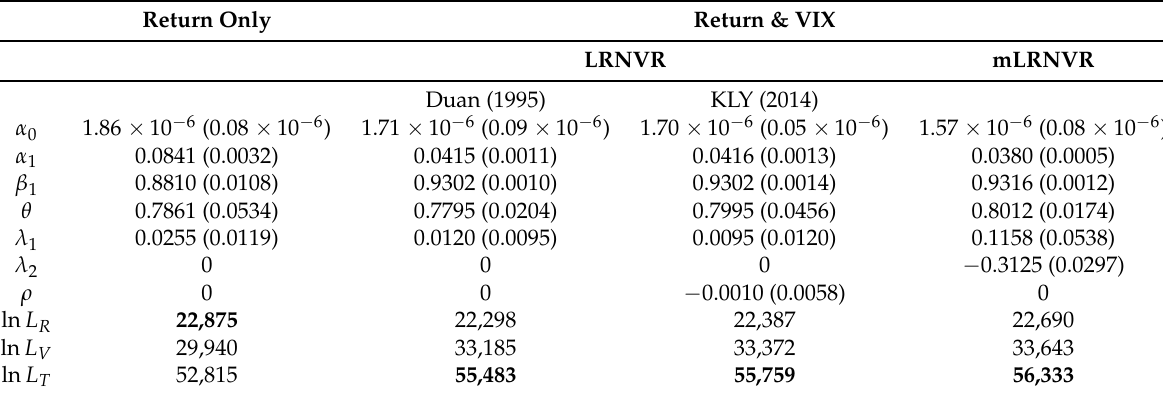
Table 3. Maximum likelihood estimates of AGARCH(1,1) model using returns data only or both returns and VIX data. The bold values indicate the log-likelihood value which is being maximized. The standard errors are provided in parentheses. We use a sample of 6928 daily data for the model estimation.